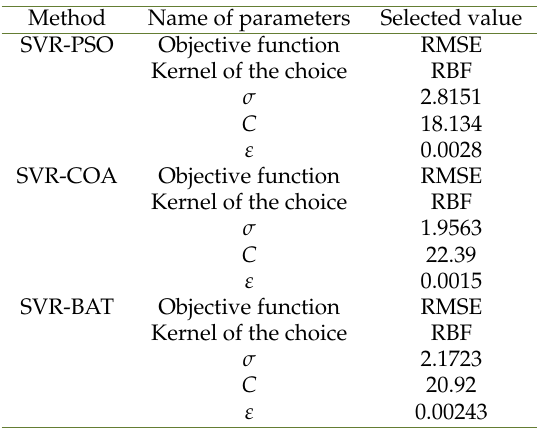
Table 3. Selected parameter to evaluate the largest